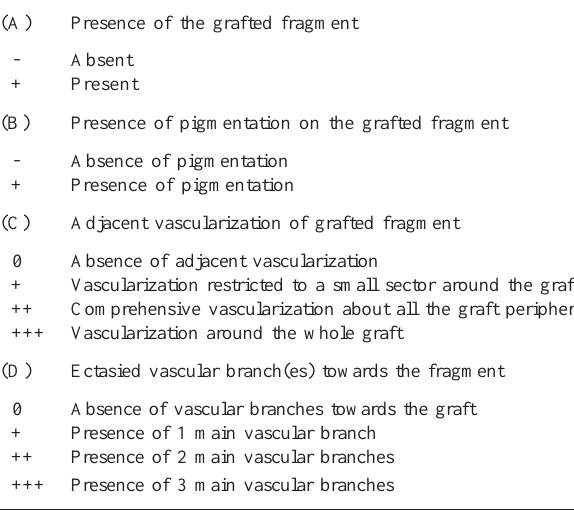
TABLE 1 - Macroscopic criteria for grafts evaluation.